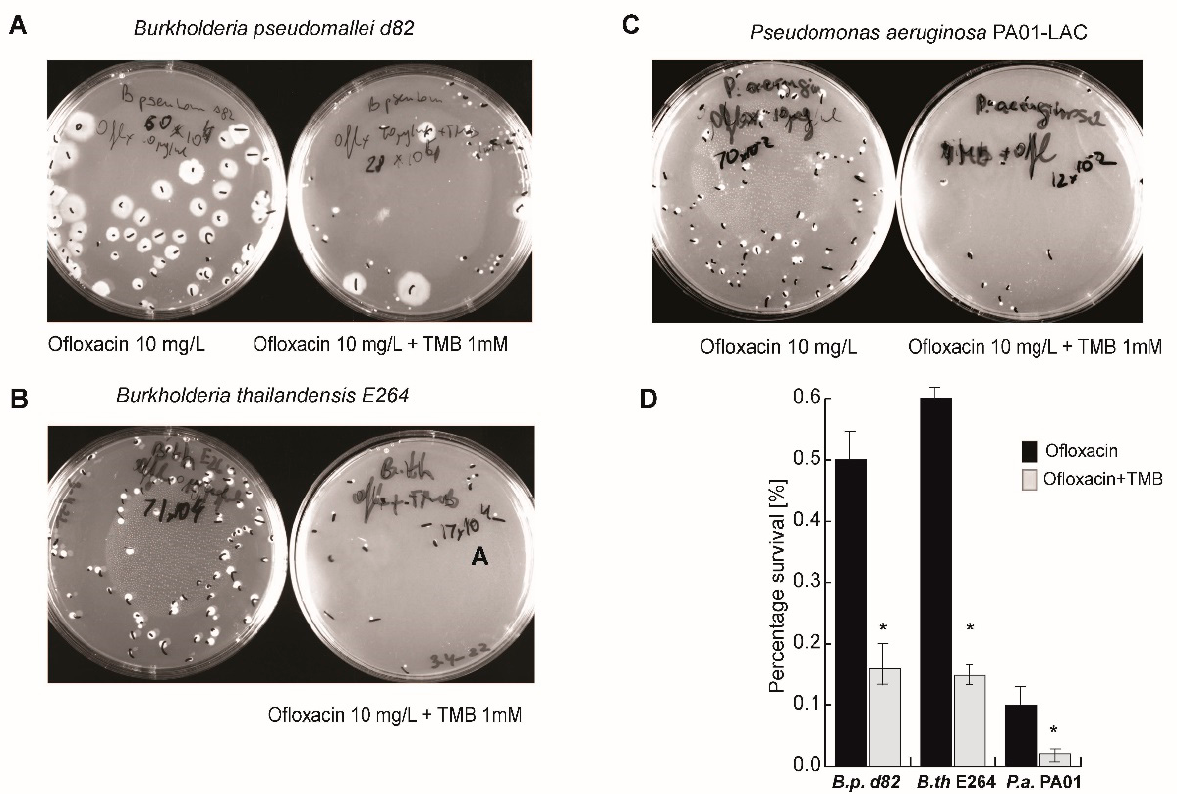
Figure 4. Fatty acid regulatory pathways contribute to bacterial persistence. Thrimethilbenzothiazole/piperazine (TMB), an inhibitor of fatty acid amide hydrolase activity (FAAH), was applied to supplement ofloxacin treatment. Early exponential phase (OD 0.2) bacterial cultures were treated with ofloxacin or with TMB (1 mM) and ofloxacin for 24 h (at 37 °C). Shown is the percentage survival of ( A ) B . pseudomallei d82; ( B ) B. thailandensis ; and ( C ) P. aeruginosa PA01-LAC cultures calculated as ratio of colony forming units (CFU) in bacterial populations treated with antibiotic/s relative to CFU counts prior to drug exposure; ( D ) average and standard deviations were calculated from four biological experiments and statistical significance (* p < 0.01) was determined with an unpaired Student’s t test.